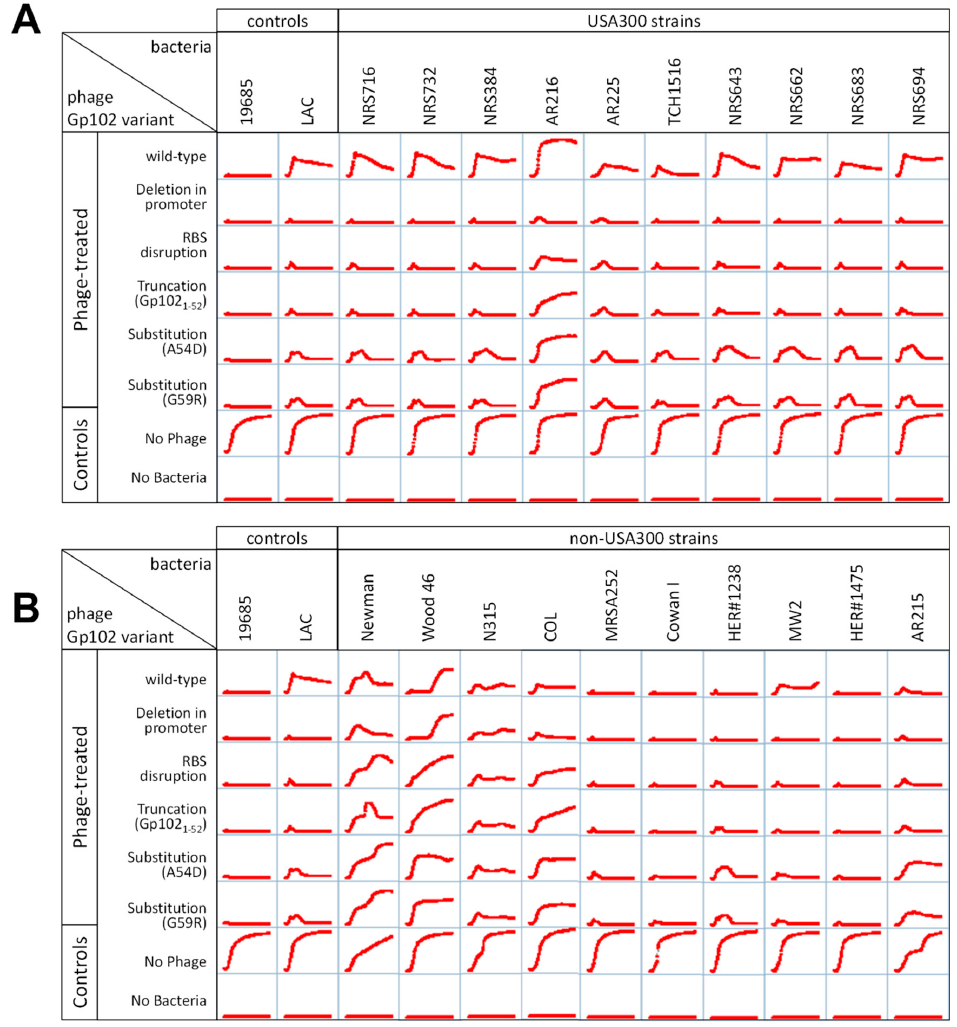
Figure 3. Effect of phage K gp102 mutants on growth of additional S. aureus strains in broth. ( A ) USA300 strains at 37 °C. ( B ) Non-USA300 strains at 37 °C.